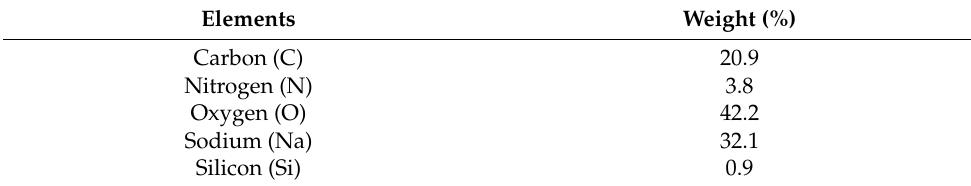
Figure 5. EDS spectroscopy of chemically extracted chitin.